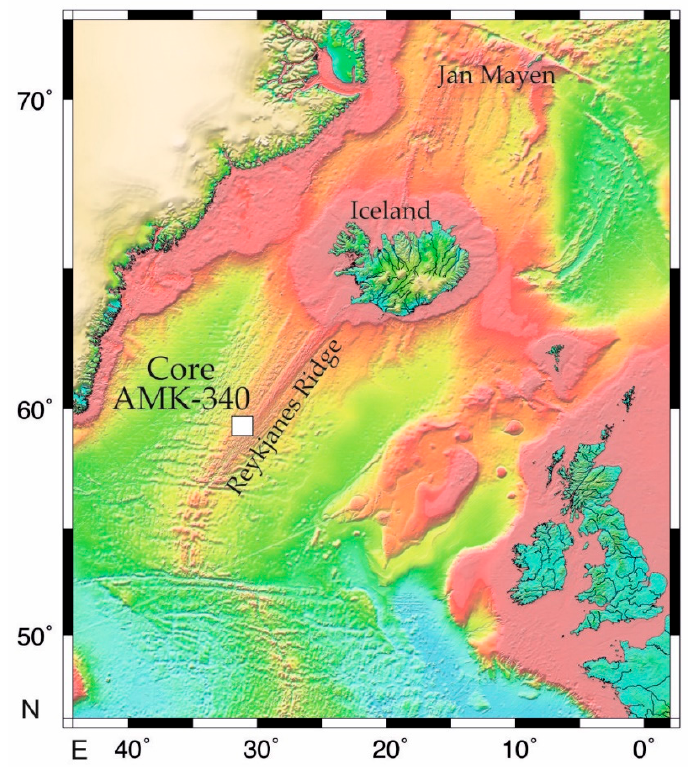
Figure 1. The geographic position of the sediment core AMK-340 (the Russian research vessel “Akademik Mstislav Keldysh” station 340). Source of the map is (https://topex.ucsd.edu/marine_topo/jpg_images/topo4.jpg).